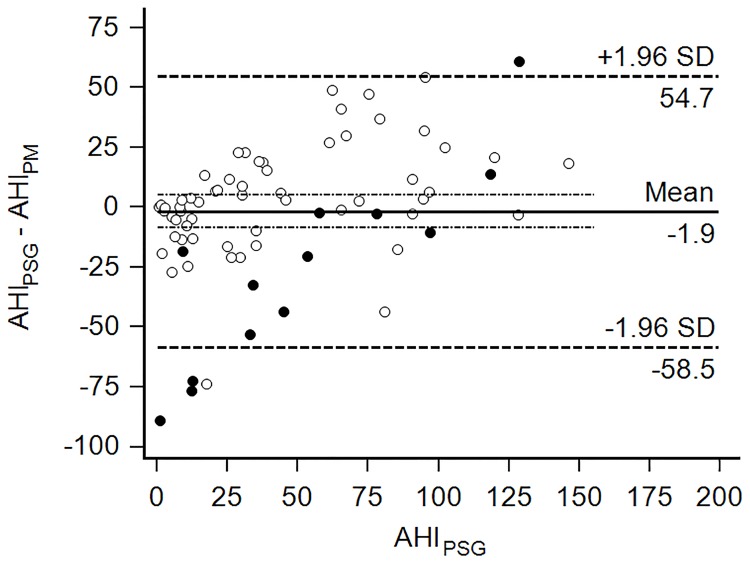
Modified Bland-Altman plot for AHIPM and AHIPSG.The difference between AHIPSG and AHIPM was plotted against AHIPSG. Dark circles represent cases in which the central apnea index on portable monitoring was ≥ 5.